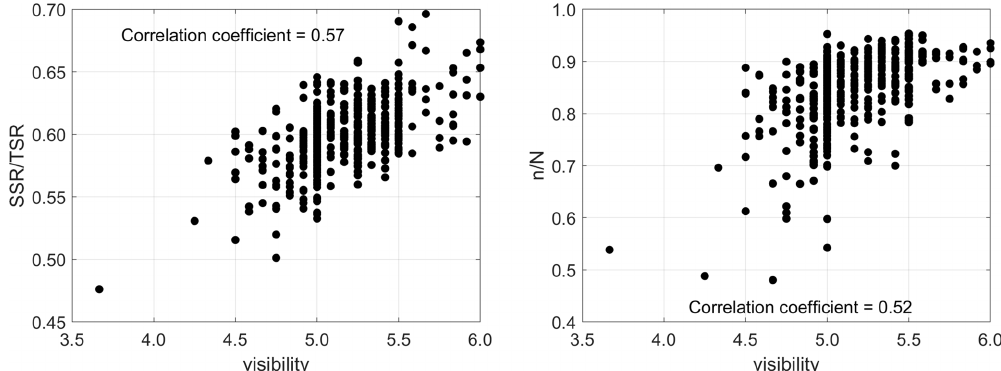
Figure 3. Daily solar transmittance and the normalized sunshine duration as functions of the mean horizontal visibility recorded from 10:00 to 15:00 on clear-sky days in the months of July to October.